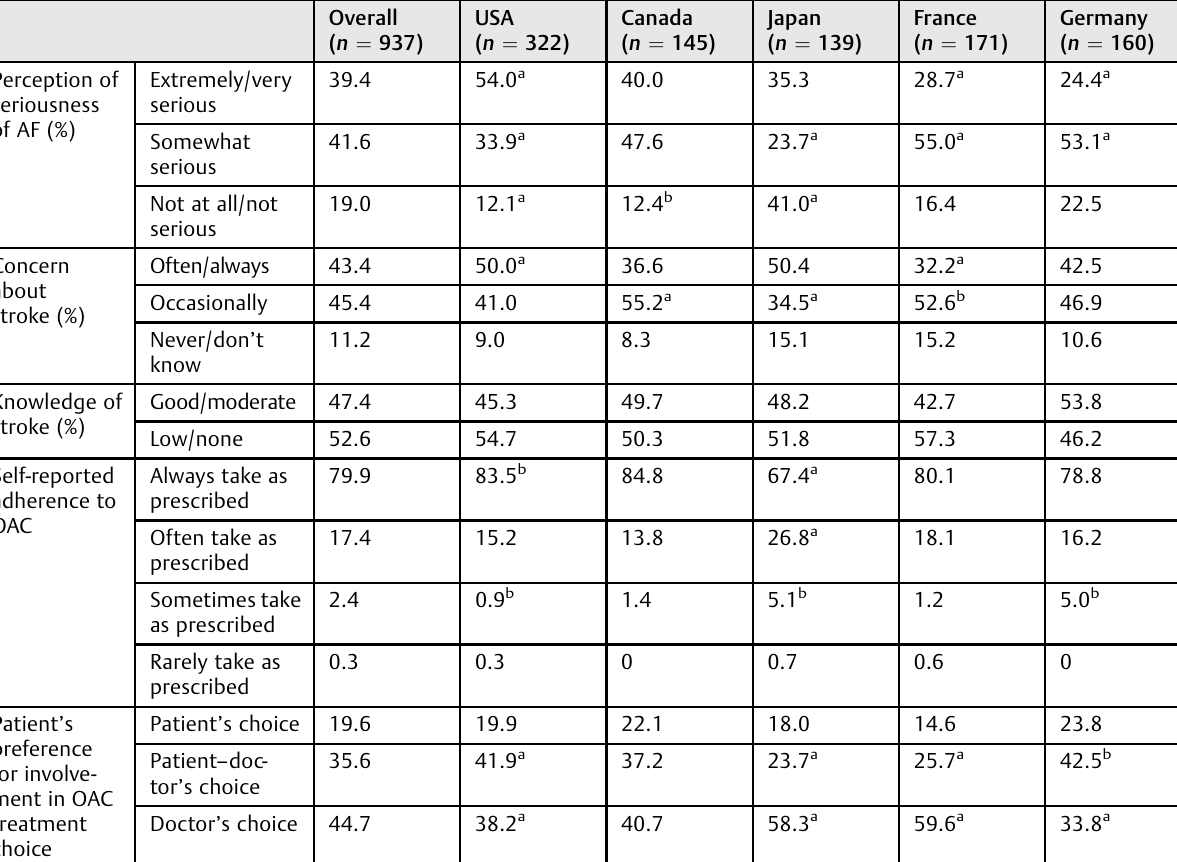
Table 2 Patients ’ perceptions about AF and stroke, level of stroke knowledge, self-reported adherence to OAC, and preference for involvement in OAC treatment choice overall and by country